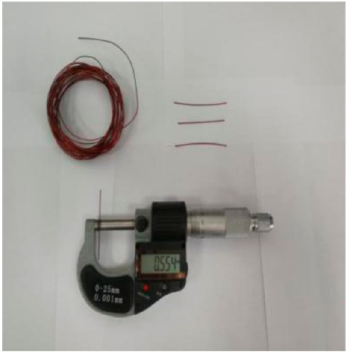
Figure 11. Experimental platform for magnet wire outer radius measurement.